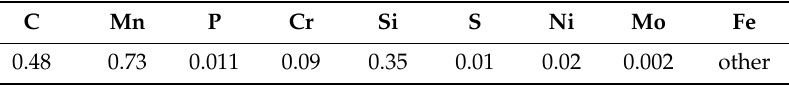
Table 1. Chemical composition (average), [%].